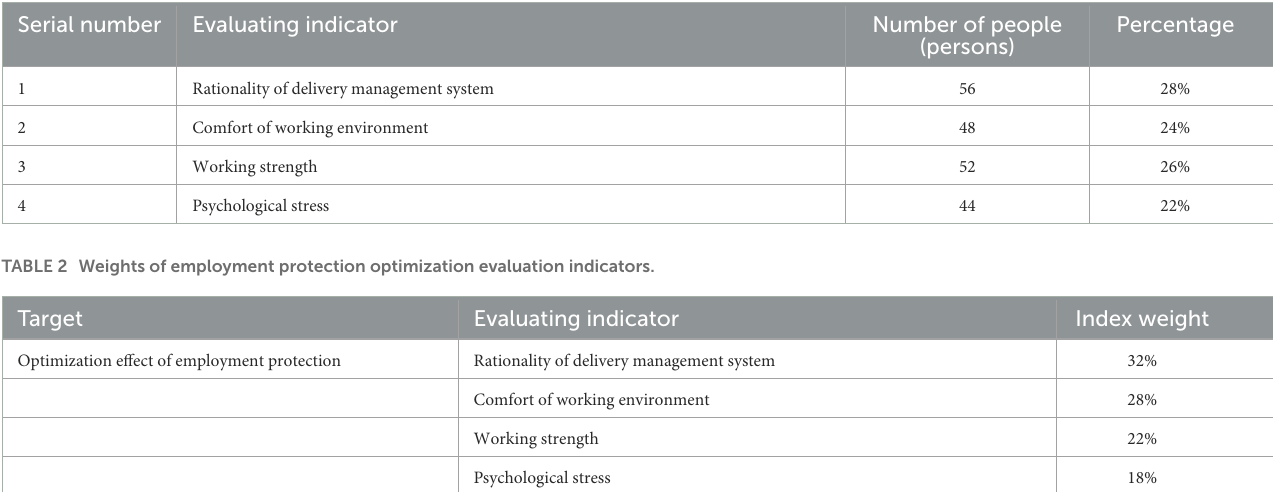
TABLE 1 Questionnaire results of the evaluation indicators of employment protection optimization.